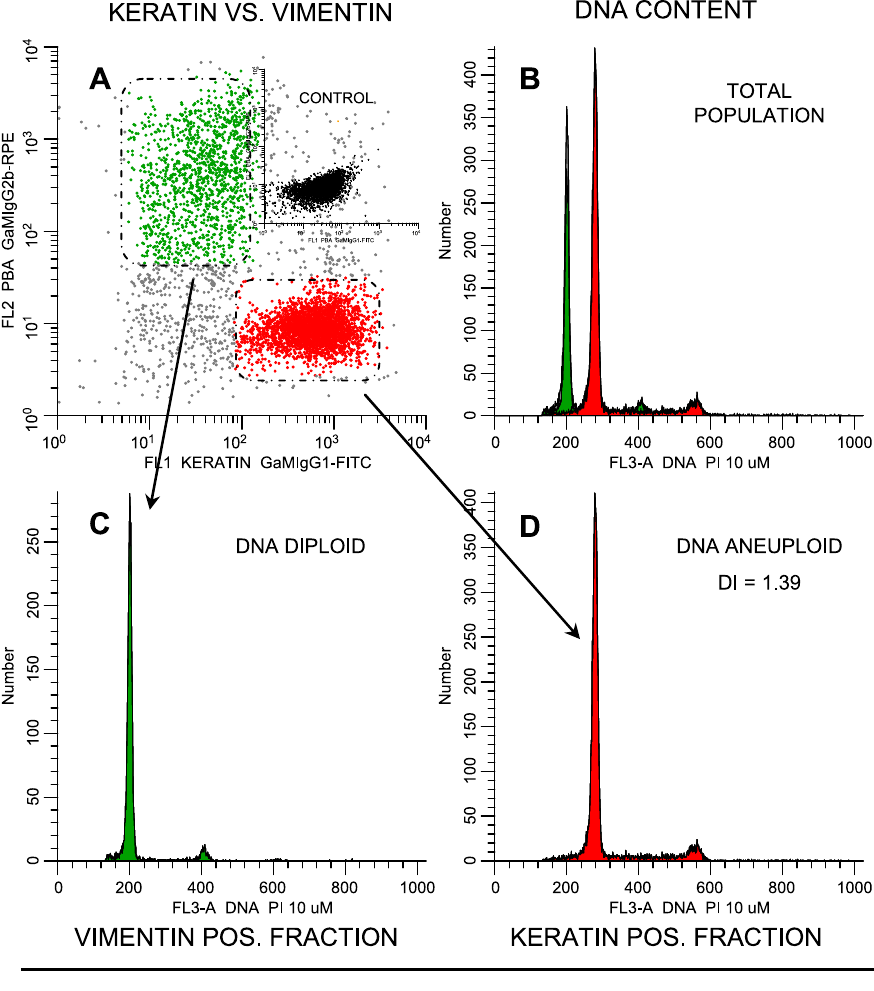
Fig. 1. Multiparameter DNA flowcytometry of a FFPE gastric cancer sample. Cells were isolated from a FFPE gastric cancer sample (Y5), stained as described and analyzed on a FACSCalibur flow cytometer. (A) Keratin versus vimentin dot plot. Inlay: negative control only stained for DNA. (B) DNA histogram of the total cell suspension showing a bimodal DNA histogram. (C) Gating on the vimentin-positive cell fraction (green) yields a unimodal DNA histogram representing stromal cells. (D) Gating on the keratin-positive cell fraction also reveals unimodal DNA histogram, with a DI of 1.39, representing gastric carcinoma